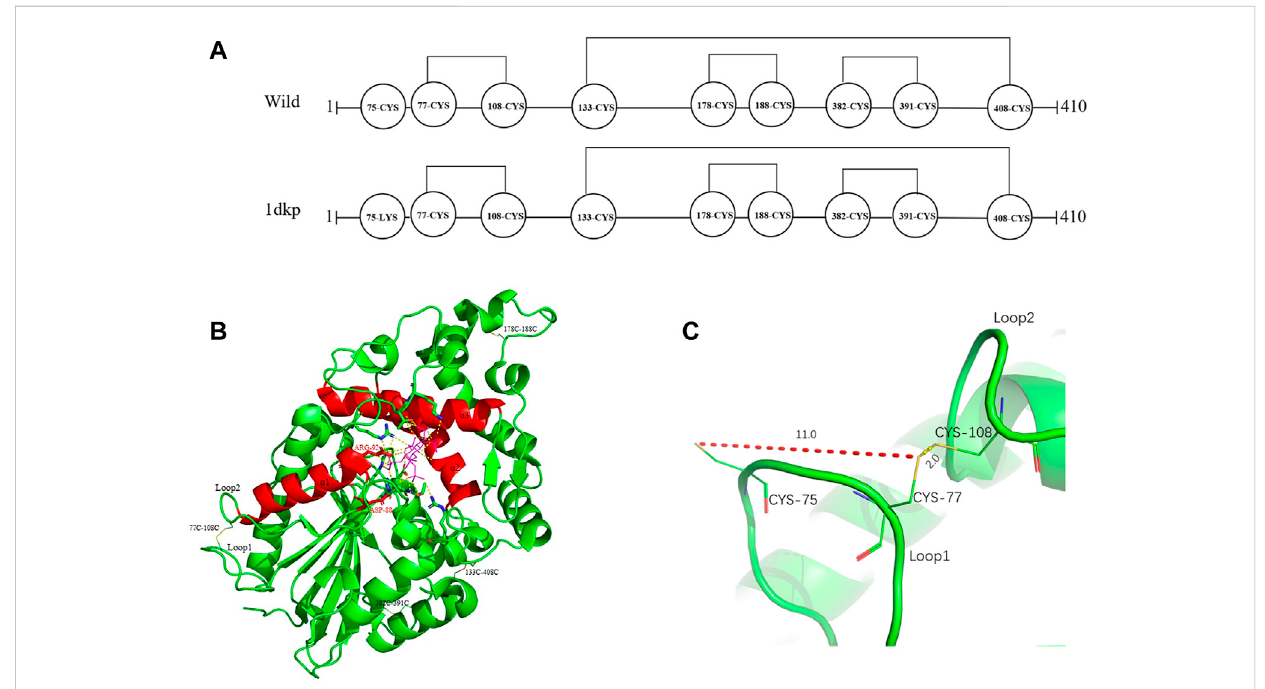
Distribution of disul fi de bonds in E. coli phytase and their effects on phytase thermostability. (A) Diagram of the distribution of disul fi de bonds in E. coli phytase. (B) Overallstructure ofphytase, withdisul fi debondsin yellowand theactive pocket inred. (C) Formation oftheC77 – C108 disul fi debond and nearby residues.